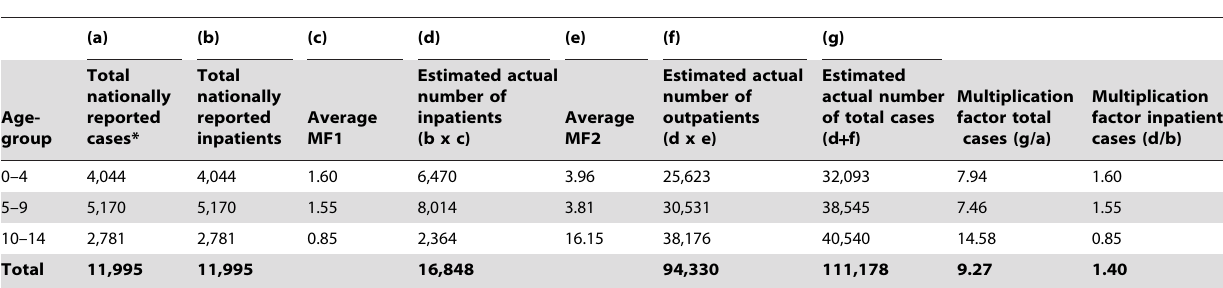
Table 3. Median reported dengue cases and application of age-group specific multiplication factors (MF), Cambodia